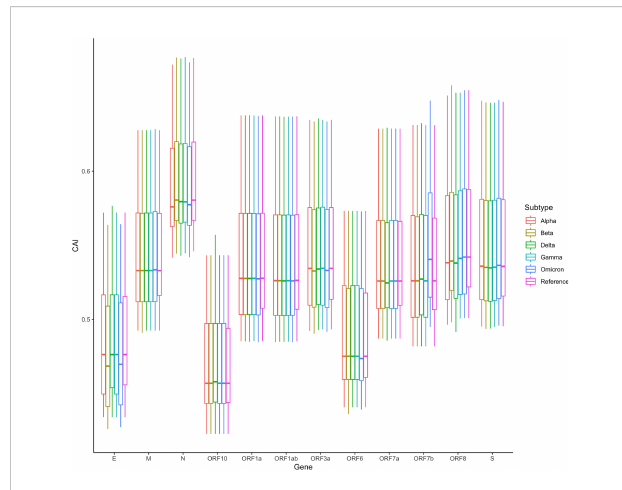
FIGURE 12 The overall CAI value distribution of SARS-CoV-2 ORFs for different variants of concern (VOCs) in all cell types/large groups from the lung scRNA-seq dataset shown by box plot. Each box shows the CAI